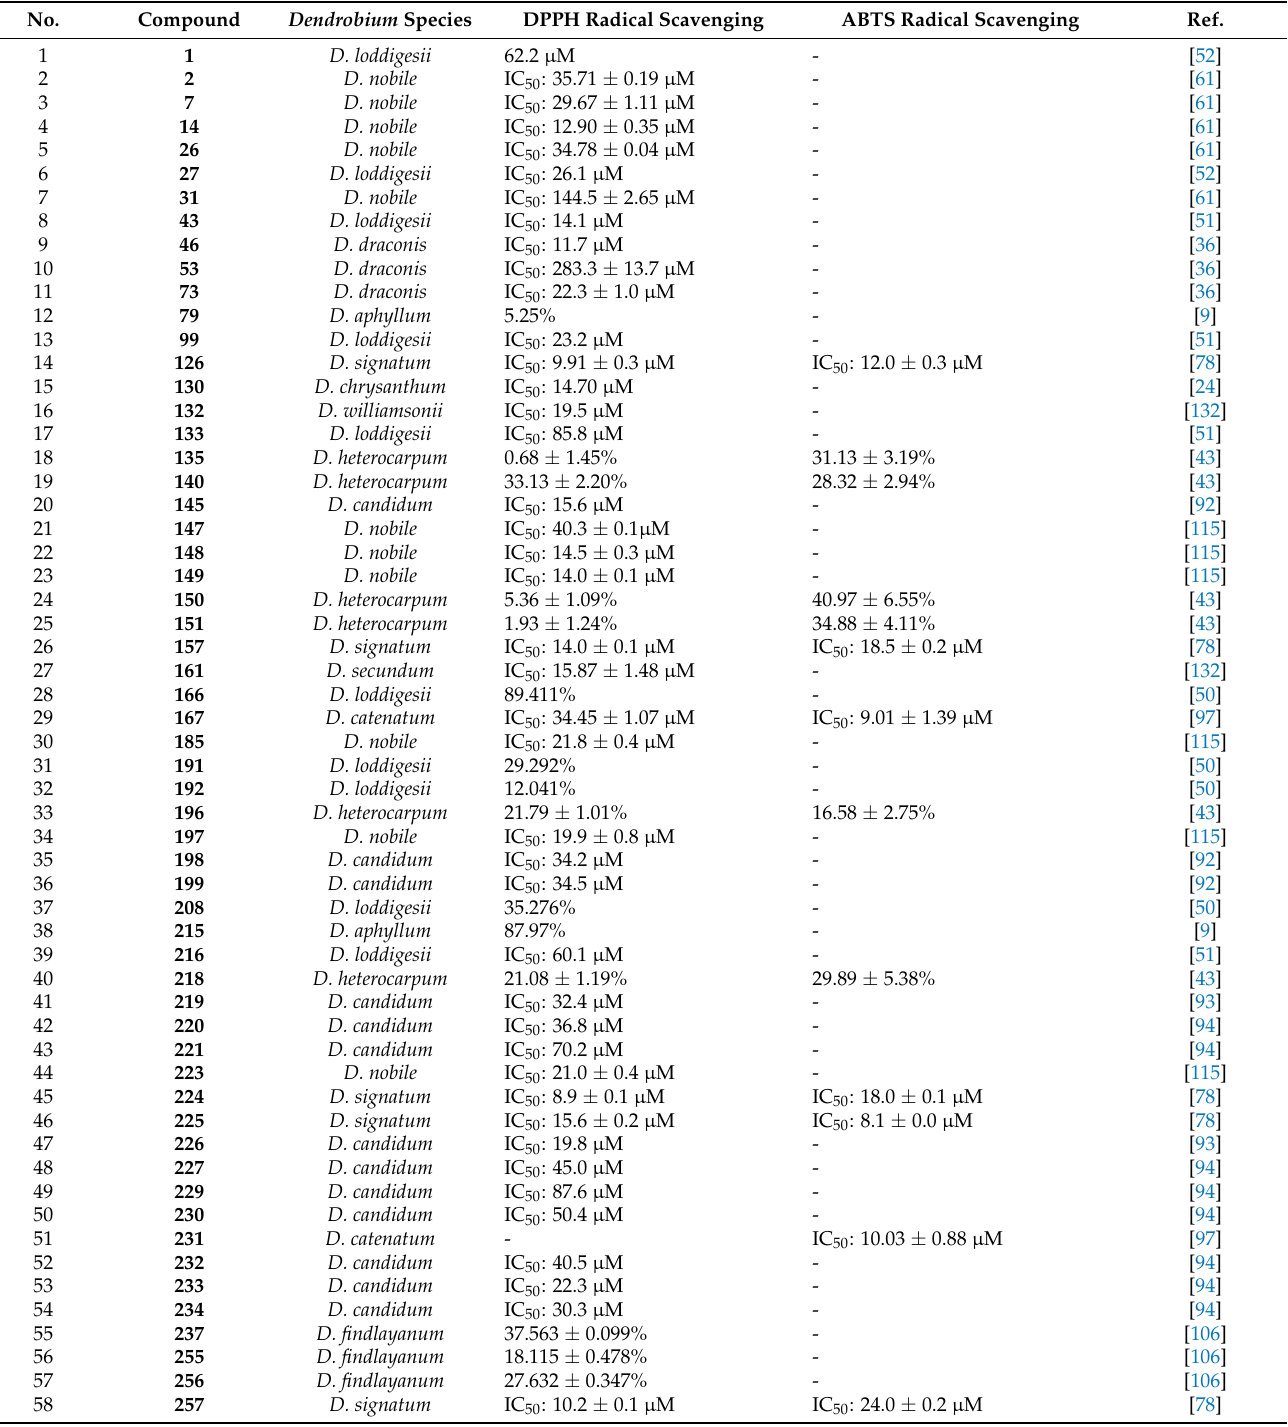
Table 3. Antioxidant activity of stilbene compounds isolated from Dendrobium